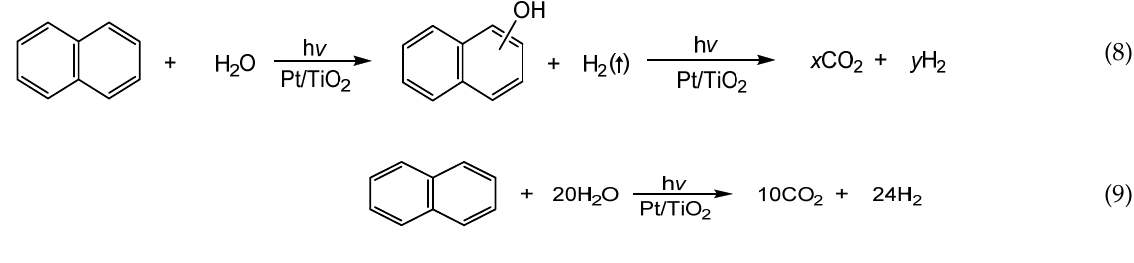
Table 2. Selectivity of total naphthalenols formation over different Pt ‐ TiO 2 photocatalysts. Photocatalyst Property